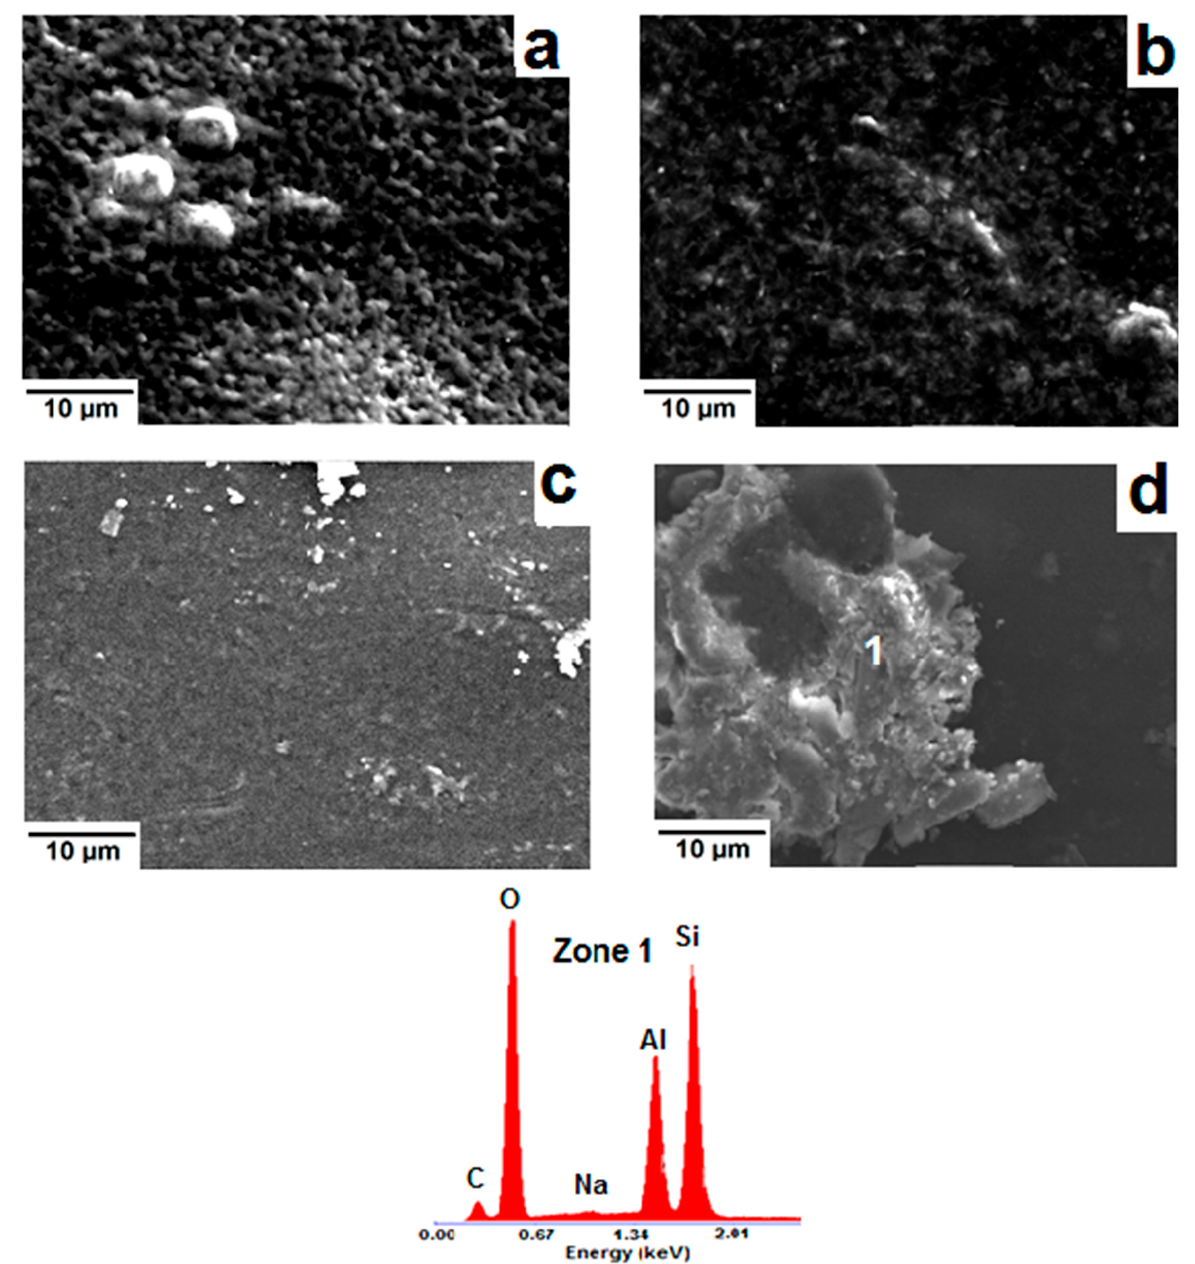
Figure 9. SEM micrographs of the α -chitosan ( a ) and the β -chitosan ( b ) films composed of 25 wt.% palygorskite. ( c , d ) are SEM micrographs of the α -chitosan and the β -chitosan films containing 3 wt.% GCM. Zone 1: EDS spectrum of the coarse aggregate shown in the micrograph ( d ).